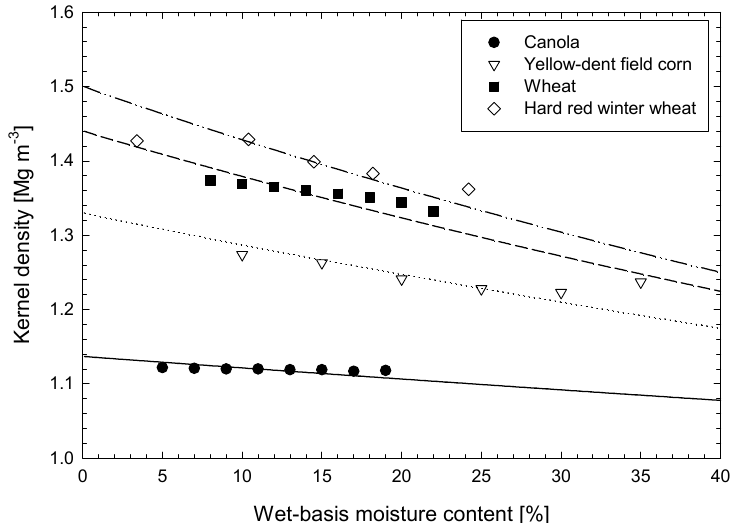
Figure 6. Measured kernel densities of canola, wheat, hard red winter wheat (all digitized from [126]) and corn (digitized from [127]) compared to modeled density using Equation (17) in terms of wet-basis moisture content.